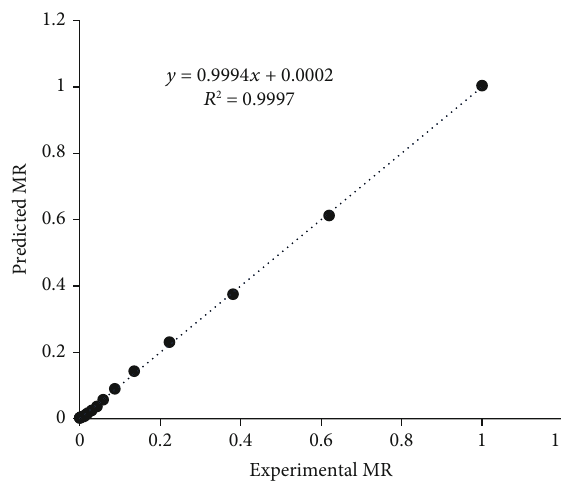
Figure 4: Comparison of predicted moisture ratio (MR) by modi fi ed Herndason and Pabis model with observed MR for refractance window